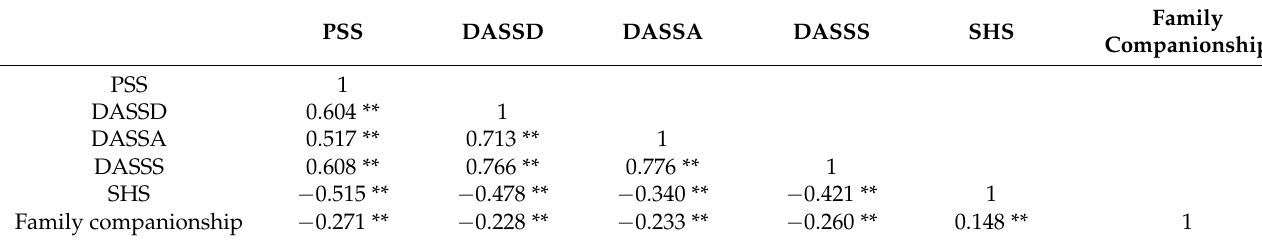
Table 4. The correlation of variables used in the